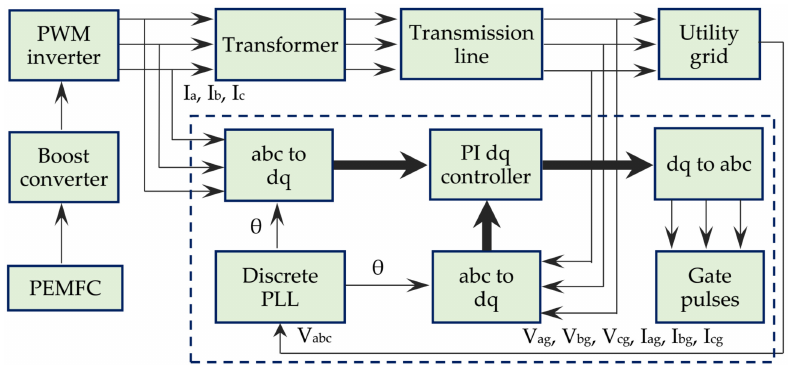
Figure 8. Block diagram of a PEMFC based power plant.